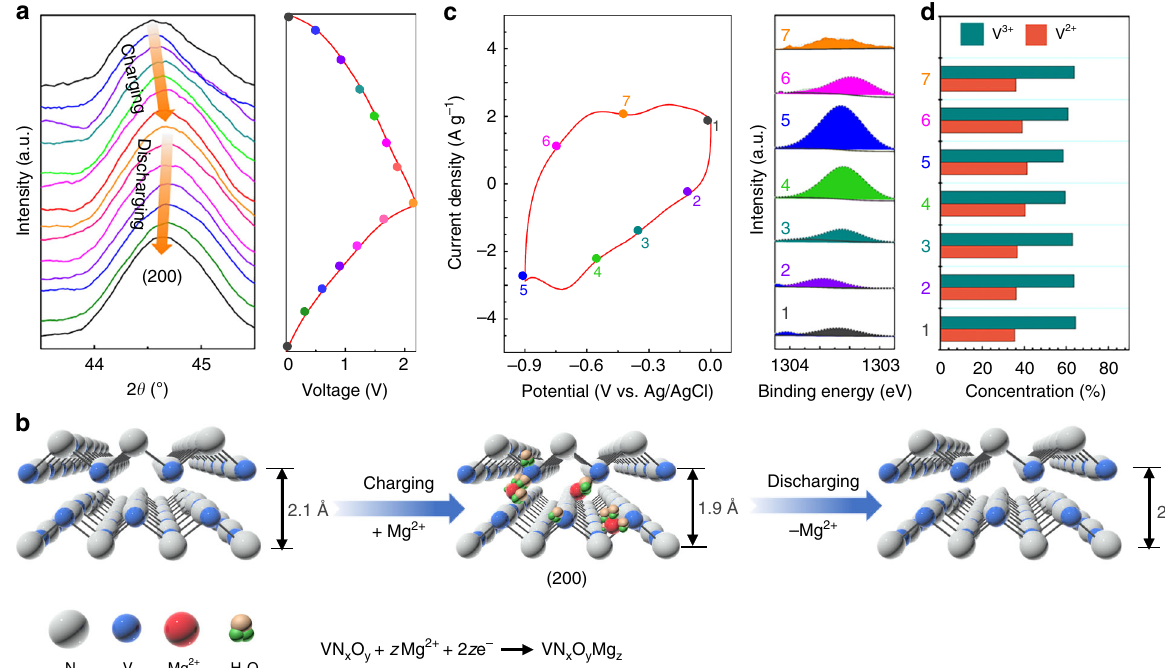
Fig. 3 Electrochemical reaction mechanism of VN in a neutral MgSO 4 electrolyte. a Operando XRD patterns of VN during the charge/discharge process (current density: 0.1 A g − 1 ). b Schematic diagram showing the contraction and expansion of the (200) crystal plane during the charge/discharge process. c Ex situ XPS Mg 1 s spectra at different potentials during the CV scan at a scan rate of 5 mV s − 1 . d Change of vanadium valence state according to XPS